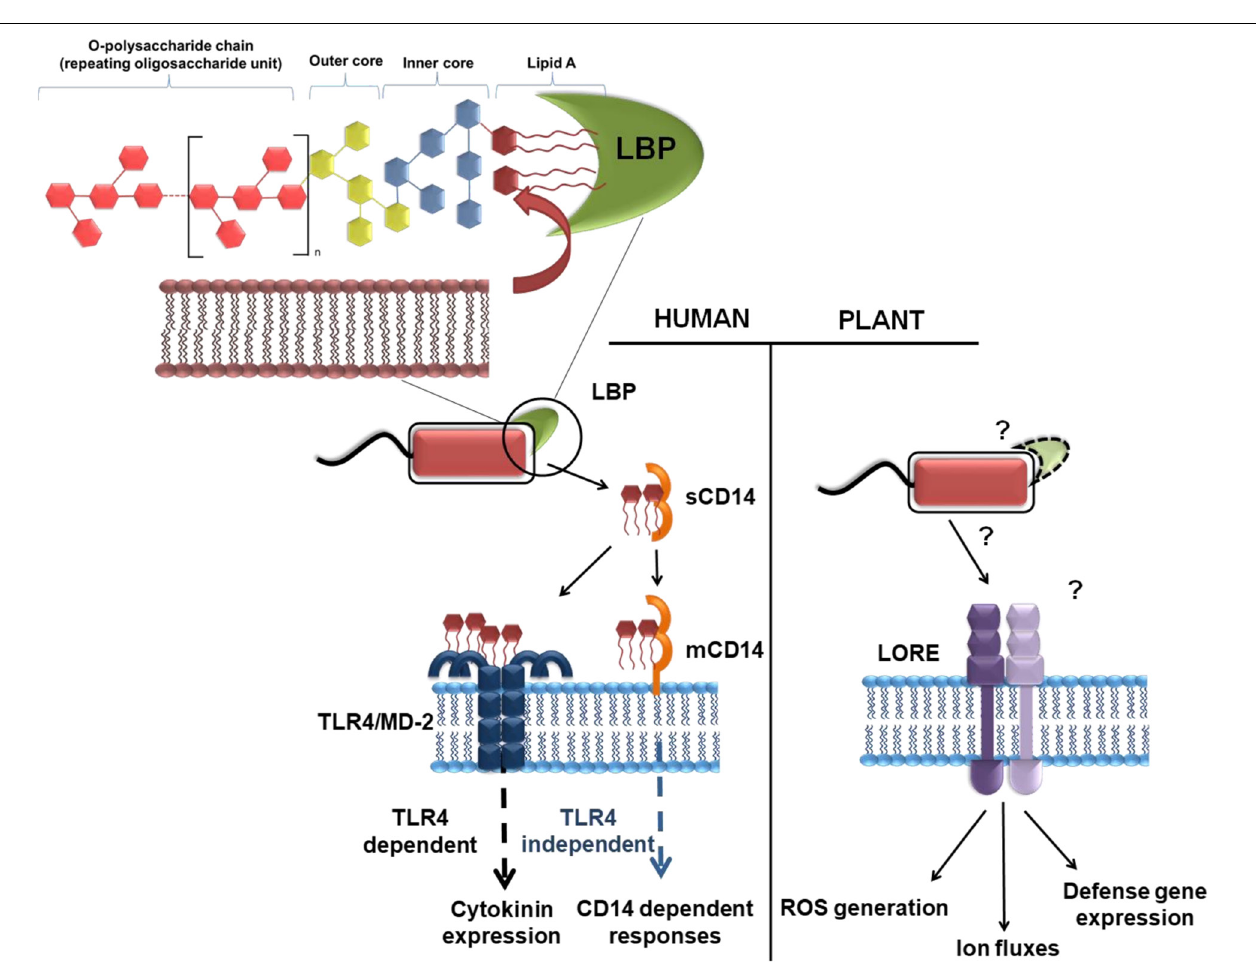
FIGURE 7 | Mechanism of LPS receptor in human and plant systems. In humans, the lipid A (LA) domain of LPS is disaggregated from the bacterial membrane by the serum protein LBP and transferred to CD14, which occurs as a soluble (sCD14) and membrane-linked (mCD14) version. CD14 can transfer LPS to the membrane-resident TLR4/MD-2 receptor complex. Depending on the cellular localization (at the plasma membrane or in endosomes upon CD14-dependent endocytosis), TLR4/MD-2/LPS complexes activate production of either interferons or cytokines through distinct signaling adapters (TIRAP/MyD88 or TRIF/TRAM). In some cell types CD14 can directly trigger immune responses. In plants, the bulb-type lectin S-domain-1 RLK LORE (Lipooligosaccharide-specific Reduced Elicitation) was identified as the first LPS receptor component in plants and mediates sensitive perception of LA domain of Pseudomonas. However, it is yet unknown whether LA directly binds directly to LORE or to an LPS-binding co-receptor to activate the receptor complex and downstream signaling [Adapted from Ranf, 2016 and reproduced with permission under Creative Commons Attribution (CC BY) license].